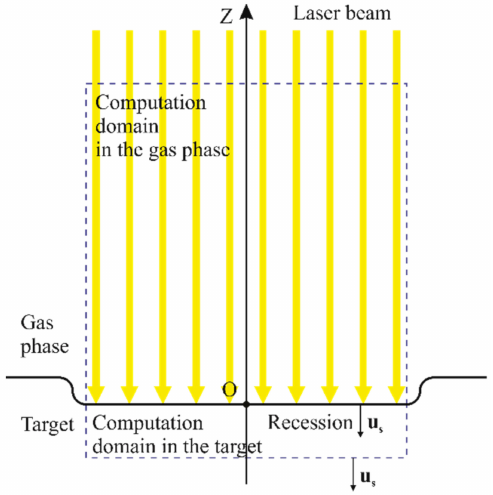
Figure 1. Interaction between the laser beam, the target, and the gas